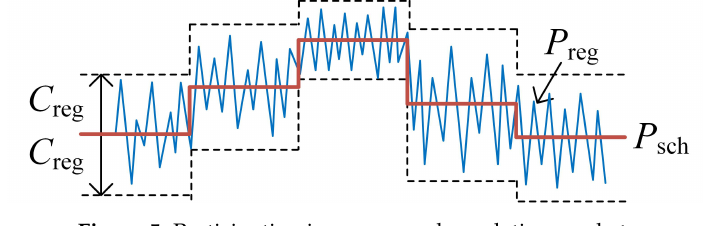
Figure 5. Participation in energy and regulation